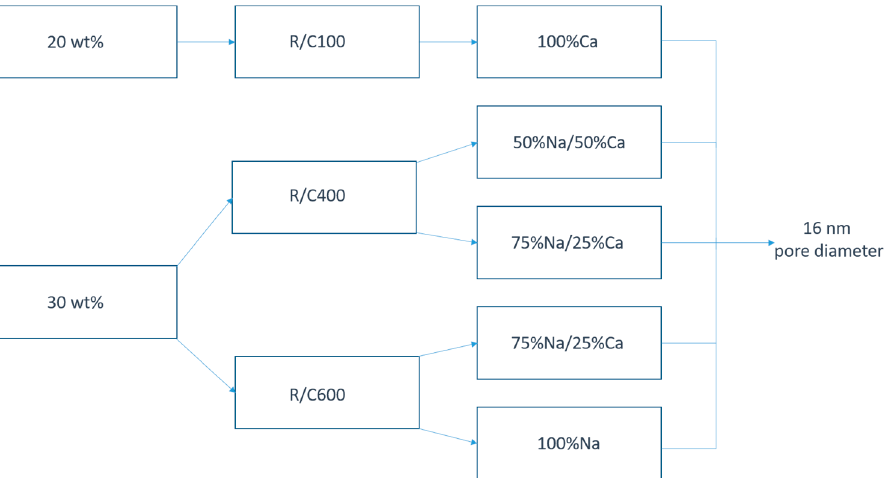
Figure 6. A schematic showing the various routes by which a gel with the same average pore diam ‐ eter can be obtained using changes in the solids content, R/C ratio, and catalyst